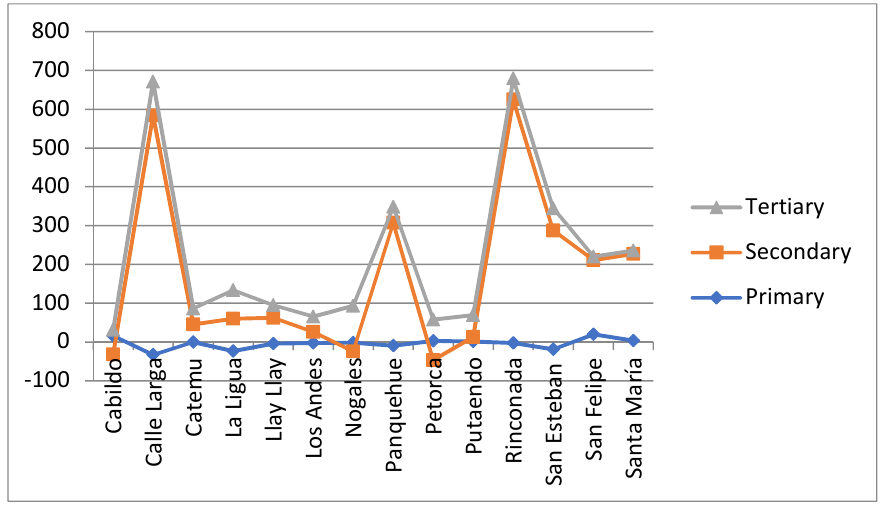
Figure 8. Decline of the primary productive sector, 1992–2017.